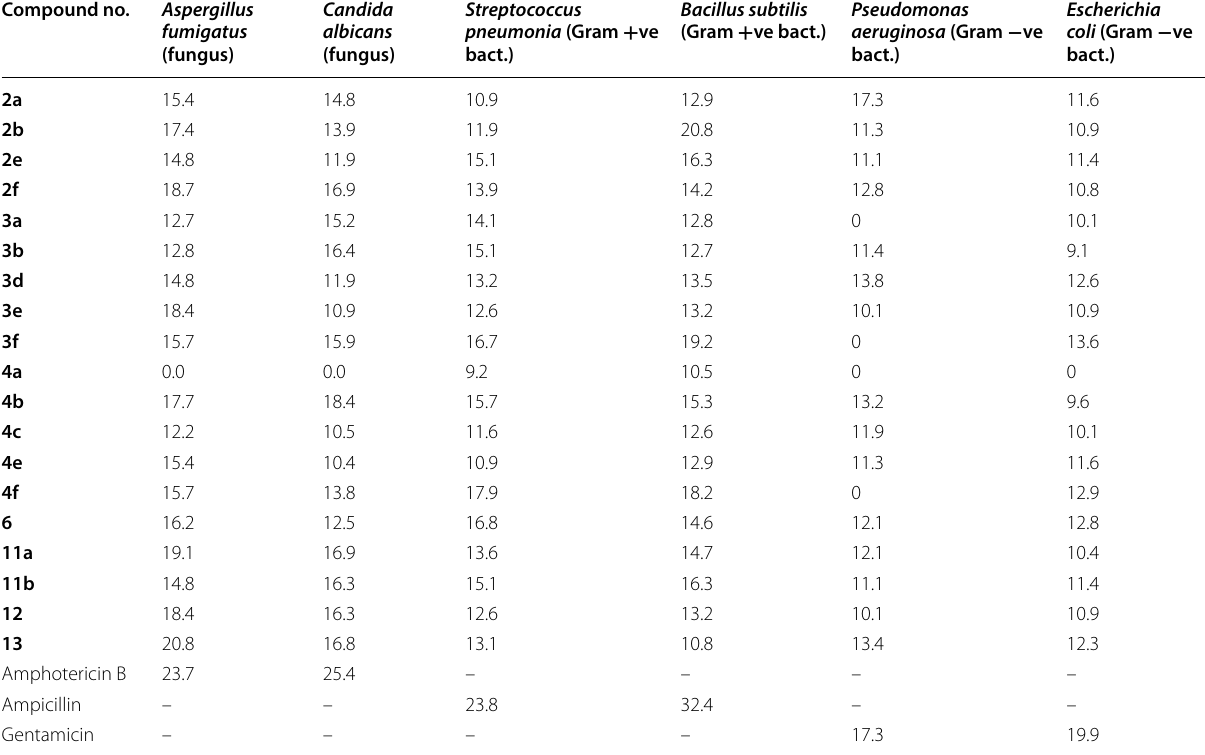
Table 2 Mean zone of inhibition beyond well diameter (6 mm) produced on a range of clinically